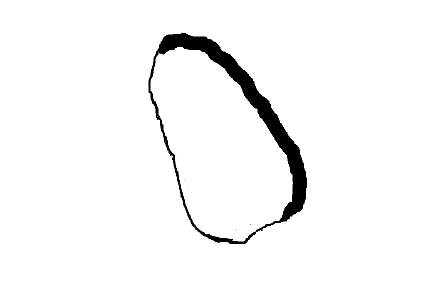
Figure 4. Refined anisotropic